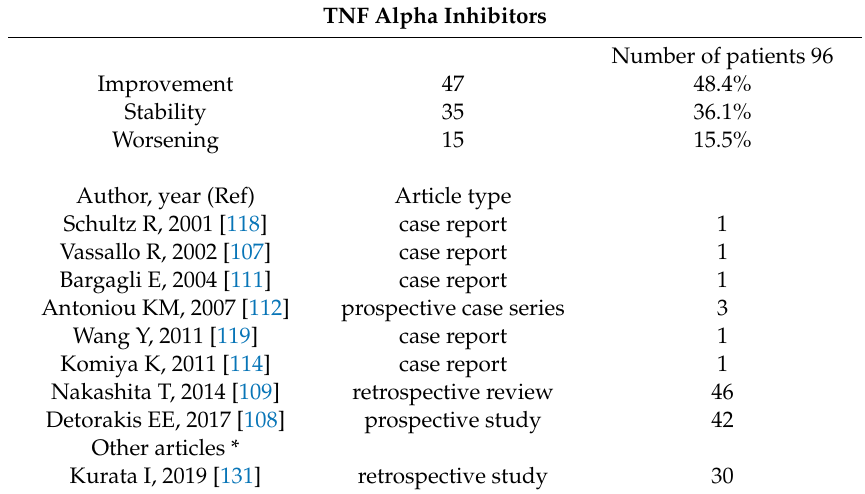
Table 4. Pulmonary e ff ects of TNFi in RA-ILD patients: a review of the literature.